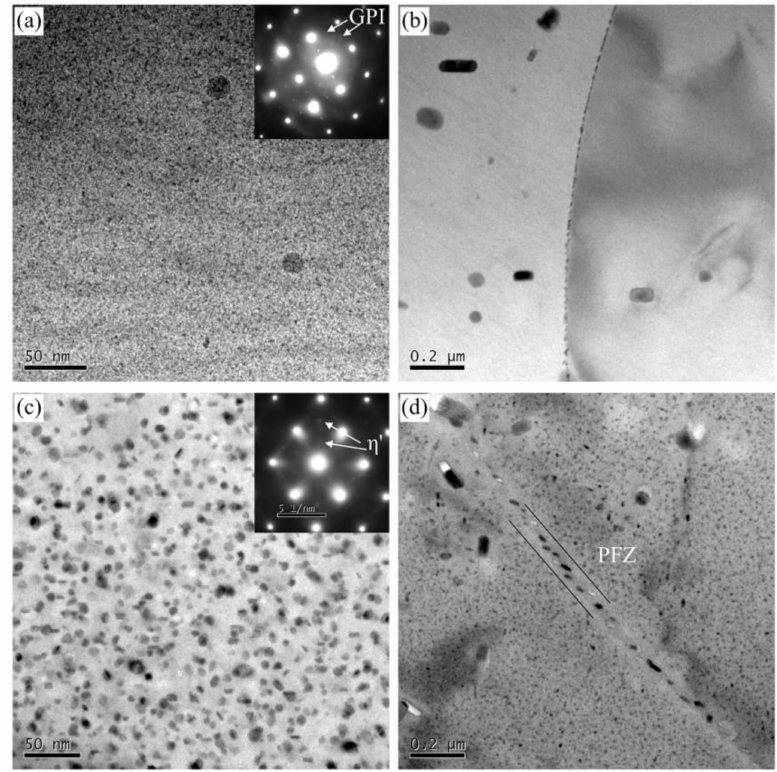
Figure 4. TEM bright-field images and corresponding SAED patterns for ( a , b ) under-aged alloy, ( c , d ) peak-aged alloy.